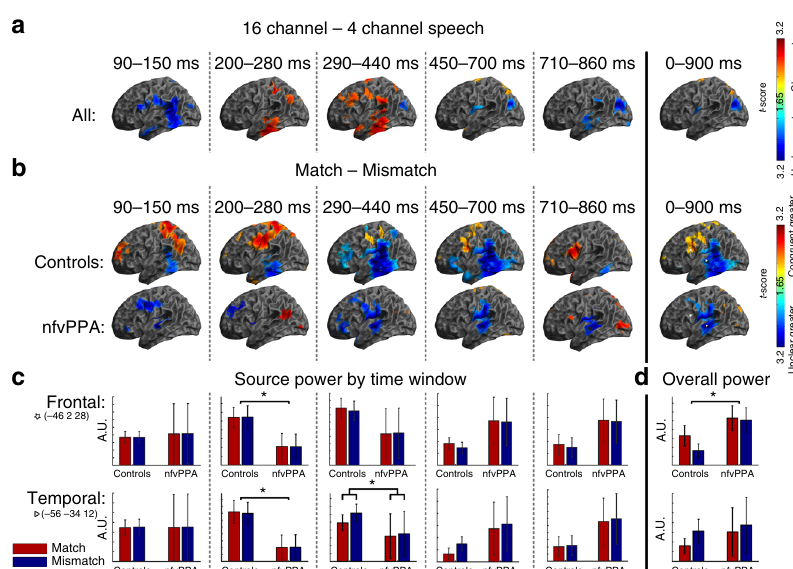
Fig. 5 Evoked source space analysis. a Evoked source reconstructions (sLORETA) for the main effect of clarity for all participants combined. b Source reconstructions for the main effect of congruency for each group individually. c Illustrative bar charts are plotted at the bottom for source power by group and condition in the frontal (IFG) and temporal (STG) regions of interest for each time window. A.U., arbitrary units. Statistically signi fi cant differences are marked by asterisks (detail in ‘ Results ’ section of text). Error bars represent the between-subject standard error of the mean (not the between condition standard error, which is much lower due to the repeated measures design). d Overall power in each source by group and condition across the whole time window of interest